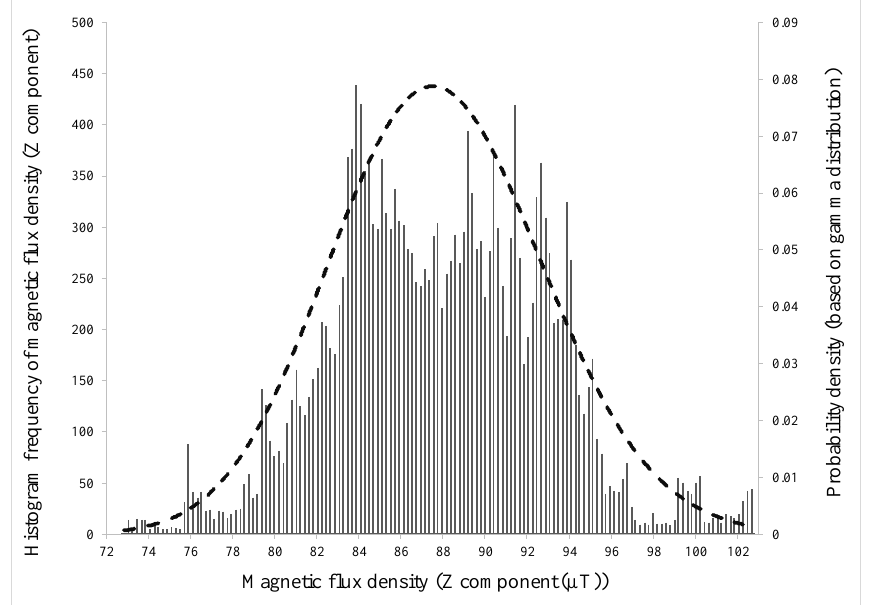
Figure 21. Histogram frequency of data in conjunction with gamma distribution probability density.